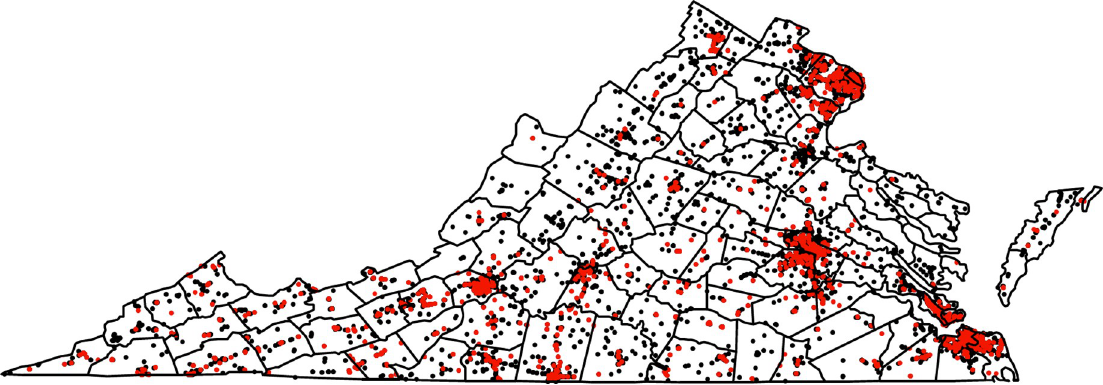
Fig 2. Locations of compliance checks (black) and sales to minor violations (red) shown with county boundaries in Virginia.